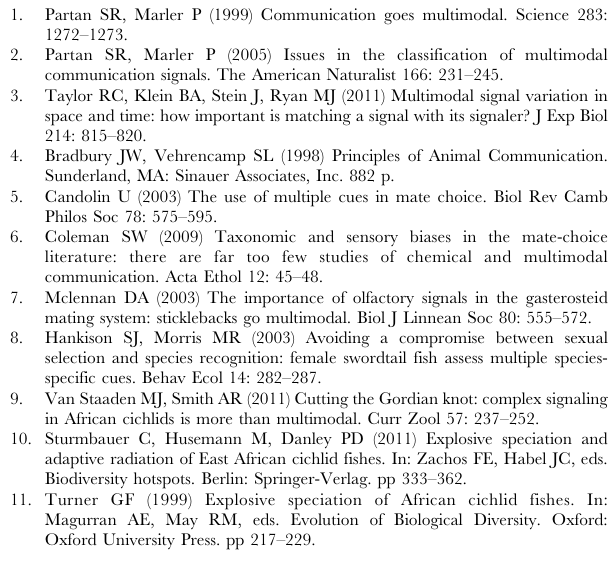
Figure 6. Gravid sexually receptive females prefer males associated with playbacks of courtship sounds over noise controls. A) Experimental tank setup for female preference trials. A gravid female was placed in the center compartment with size-matched territorial dominant males on either side. An underwater speaker in one of the male compartments played either male courtship or noise control sounds to the female while she was visually isolated. Following playback, the opaque barriers were removed and the time spent by the female in neutral and preference zones, as well as male reproductive behaviors were recorded and analyzed. B) Gravid females showed a greater relative preference (preference index) for males associated with the playback of courtship sounds compared to playbacks of control noise sounds. Data are plotted as mean 6 SE. N =10 gravid females per sound condition. C) Examples of the playback stimuli used for courtship sounds and brown noise control trials. Waveforms (top) and spectrograms (bottom) for a 1 min section of each sound type are